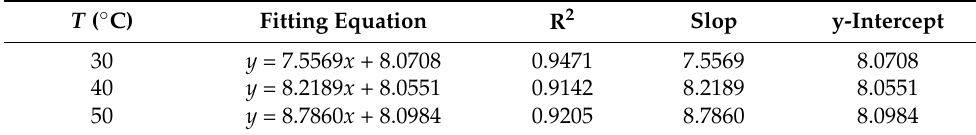
Figure 13. The relationship between ln P and n . Table 5. Fitting results of ln P and n at different temperatures.